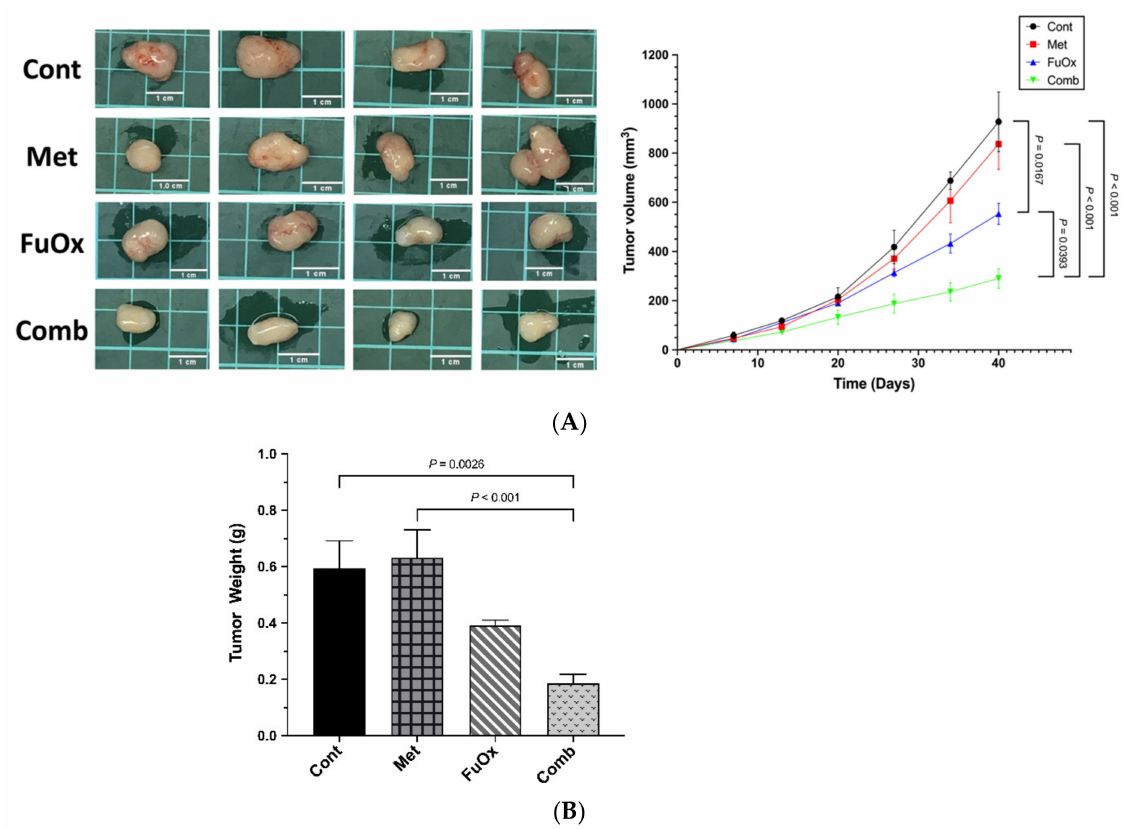
Figure 6. The combination of FuOx and metformin decreased tumor volume and tumor weight in BALB/c nude mice. HT29 was injected subcutaneously into the right flank of nude mice. Treatment was started 7 days after HT29 cell injection. Metformin (150 mg/kg) dissolved in drinking water was orally administered daily. The mice were injected with 6 mg/kg intraperitoneal oxaliplatin and 2 h later with 50 mg/kg 5-FU and 90 mg/kg leucovorin once a week for 4 weeks. ( A ) The tumor volume was measured three times per week; ( B ) the tumor weight was recorded after sacrificing at day 40. Data are presented as mean ± SEM. Cont, control; Met, metformin; FuOx, 5FU and oxaliplatin; Comb, combination of metformin and